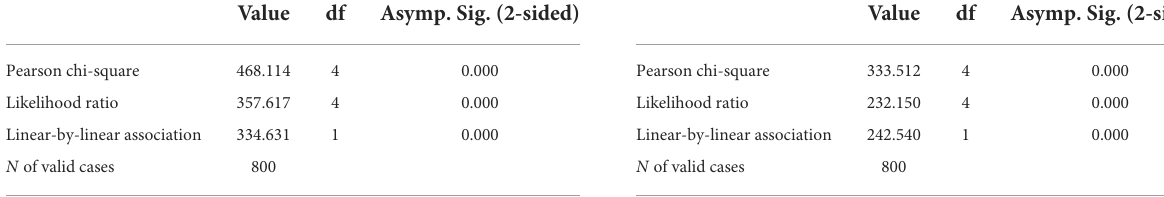
TABLE 3 Chi-square test between the dimension of reliability and satisfaction for the quality of services in public hospitals. Chi-square tests